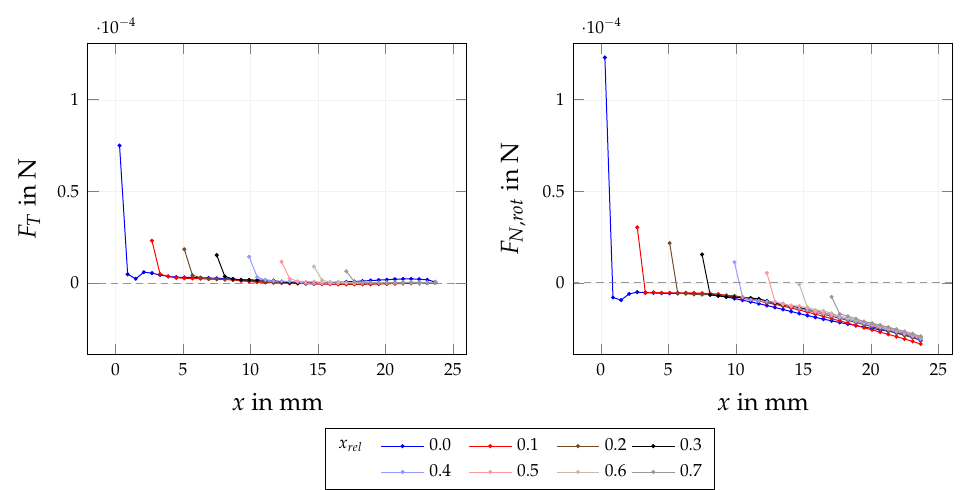
Figure 31. Distribution of tangential forces F t and rotation-induced normal forces F n , rot in central PM fragment row with partial detachment over different relative channel lengths x rel